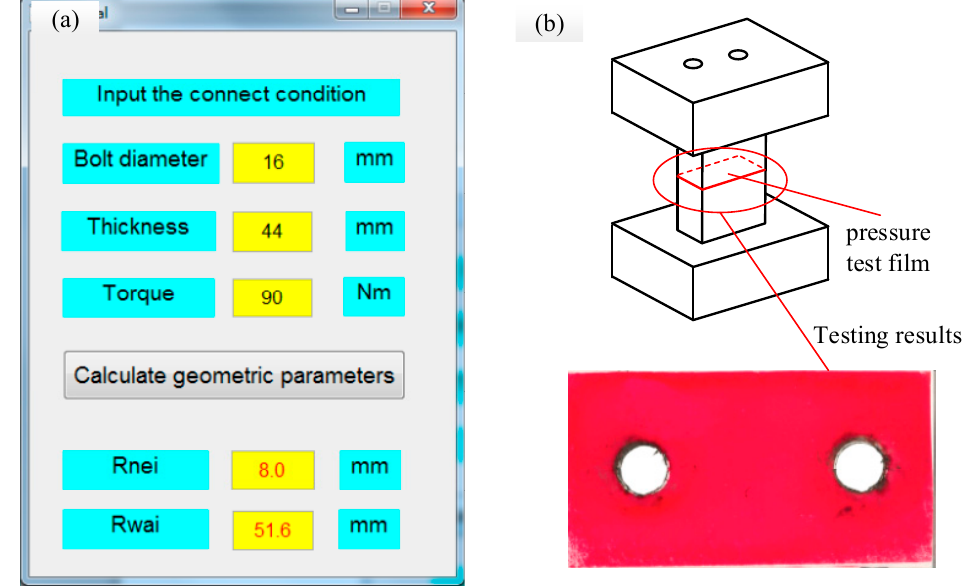
Figure 12. Geometric parameter identification: ( a ) estimate by database; ( b ) verify by pressure testing.